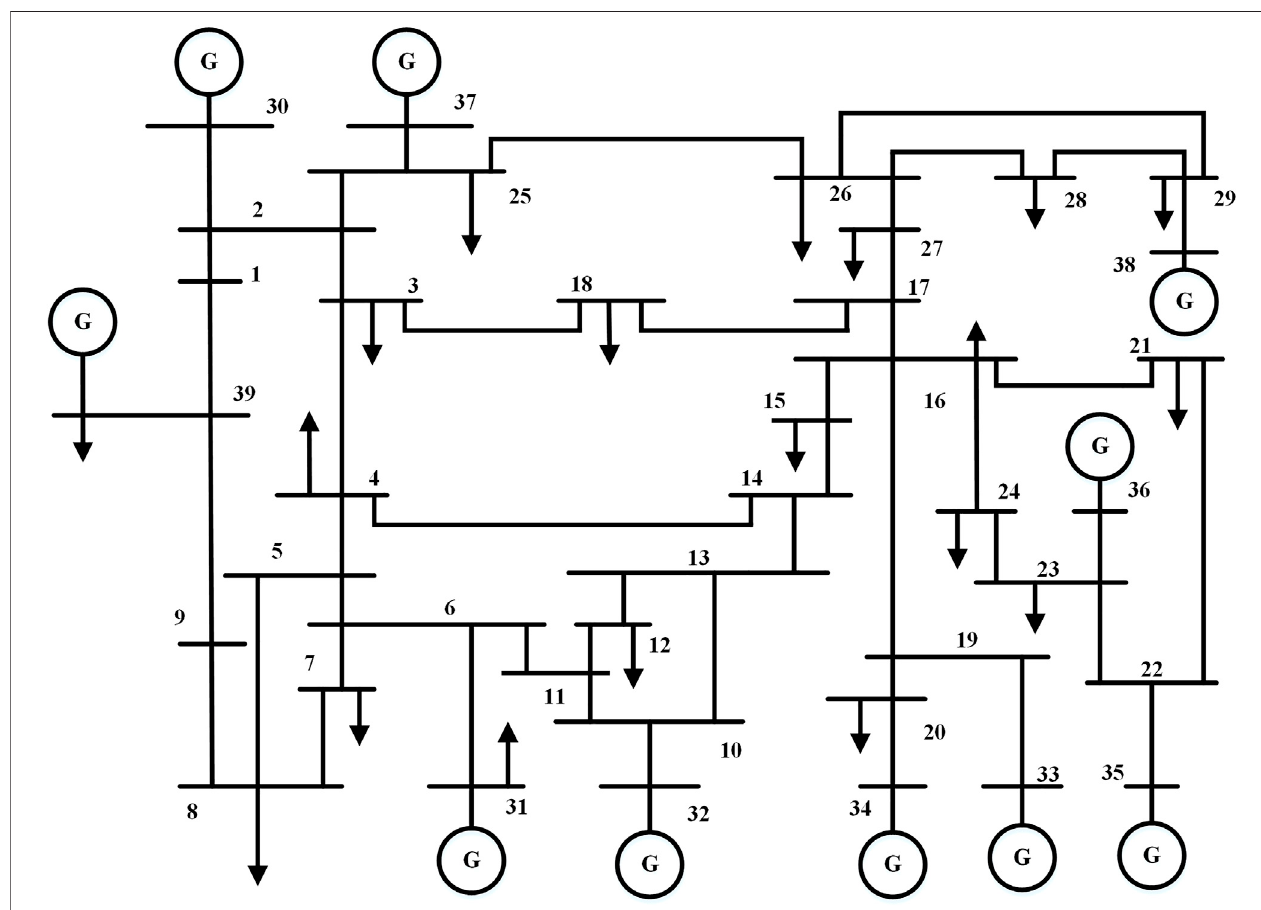
FIGURE 3 | Structure of the IEEE 39-bus system.